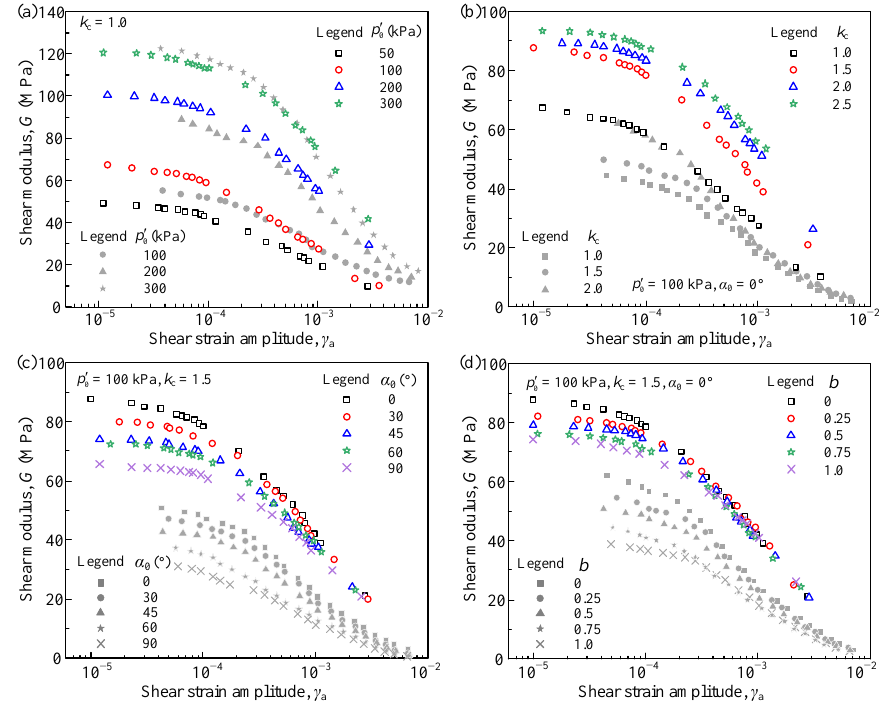
Figure 6. G versus γ a curves of isotropically and anisotropically consolidated saturated coral sand for the undrained cyclic torsional shear tests under various ( a ) effective mean principal stress, ( b ) consolidation ratio, ( c ) consolidation direction angle, and ( d ) coefficient of intermediate principal stress.